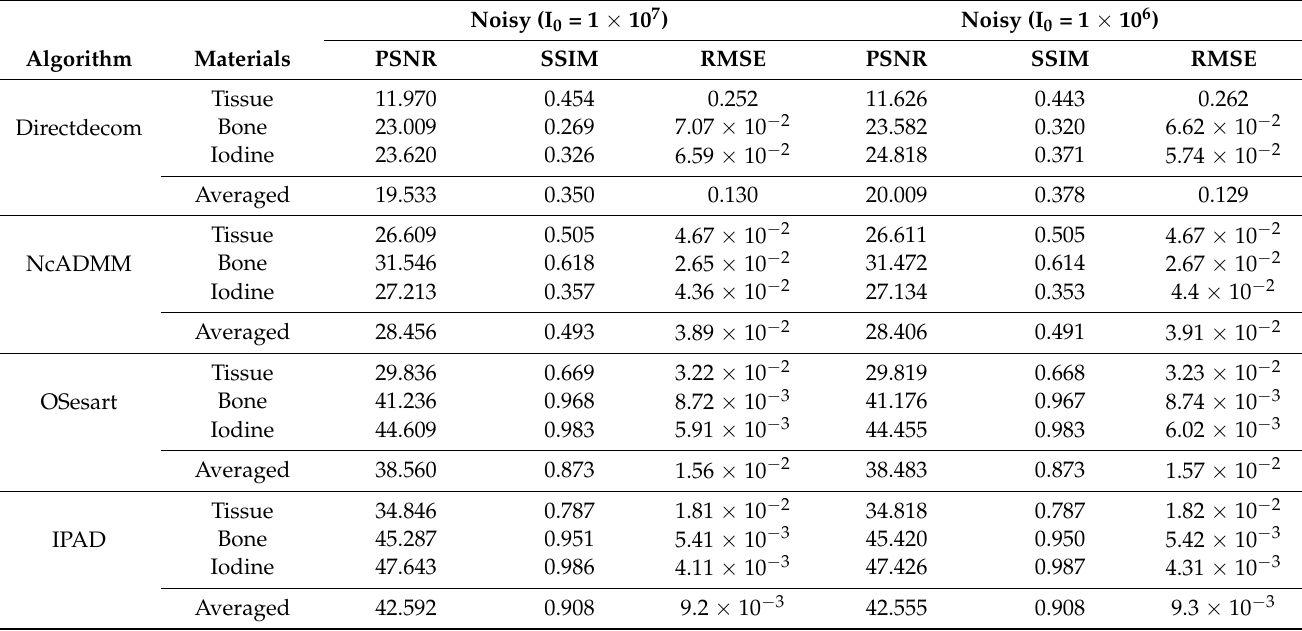
Table 1. Quantitative results of different methods.